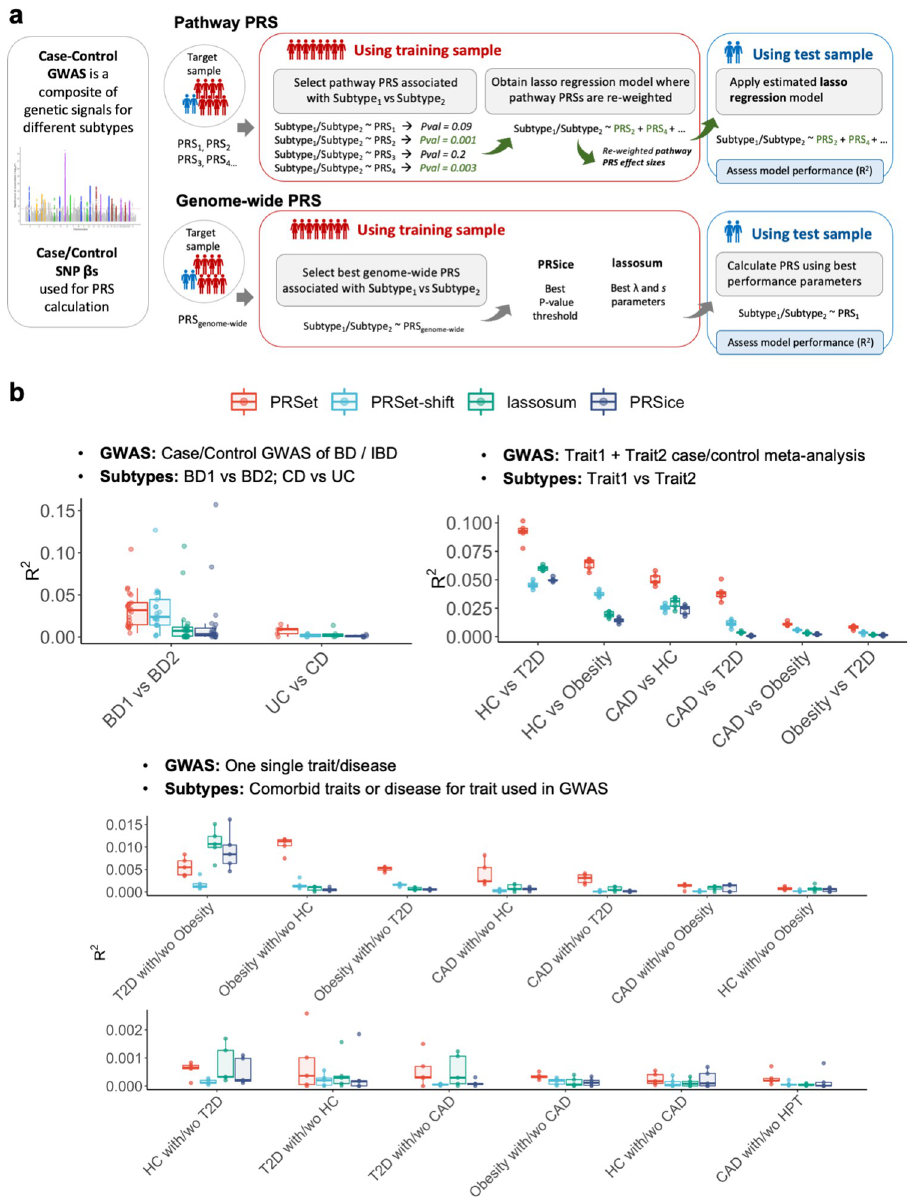
Fig 4. Stratification of disease subtypes using PRS-based methods using a supervised classification approach. A, Schematic overview of the pathway PRS and genome-wide PRS approaches for subtype classification . B, Upper left panel: Disease stratification of bipolar disorder (BD) and inflammatory bowel disease (IBD) and its subtypes; Bipolar disorder I (BD1), Bipolar disorder II (BD2), Crohn’s disease (CD) and ulcerative colitis (UC). Upper right panel, Disease stratification of pseudo subtypes of paired major diseases. Subtypes are defined as one major disease vs another. Lower panel , Disease stratification of major diseases comorbid subtypes. Subtypes are defined as cases of a major disease with vs without a risk/factor or comorbid trait. T2D, Type 2 Diabetes; CAD, coronary artery disease; obesity (body mass index > 30); HC, hypercholesterolemia (low-density lipoproteins > 4.9 mmol/L). HPT hypertension (systolic blood pressure > 140 mm Hg and diastolic blood pressure > 90 mm Hg). Colours indicate the software used to calculate enrichment: Red, PRSet; Light Blue, PRSet with 5Mbp shift; Green, lassosum; Dark blue, PRSice.